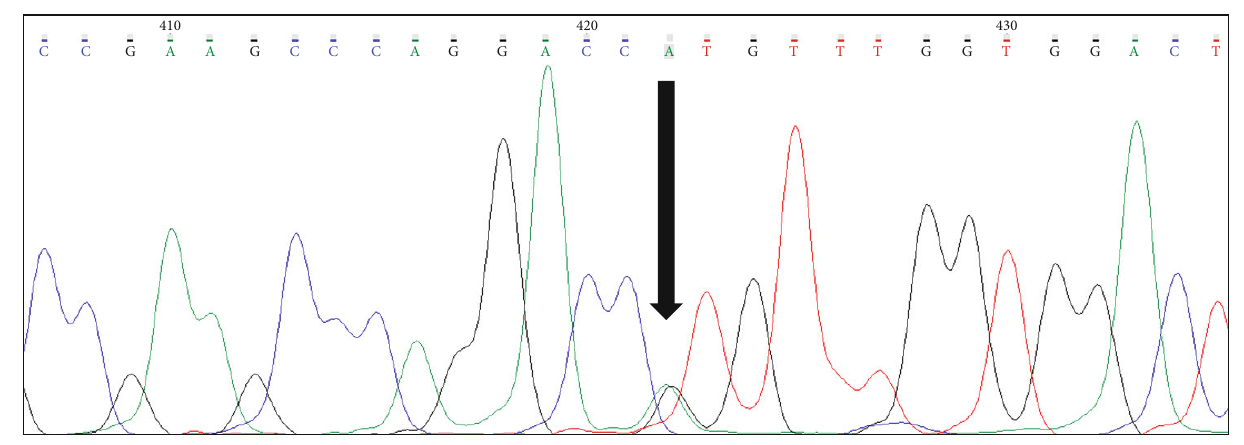
Figure 3: Sanger sequences of three identi fi ed variants in ARAP3